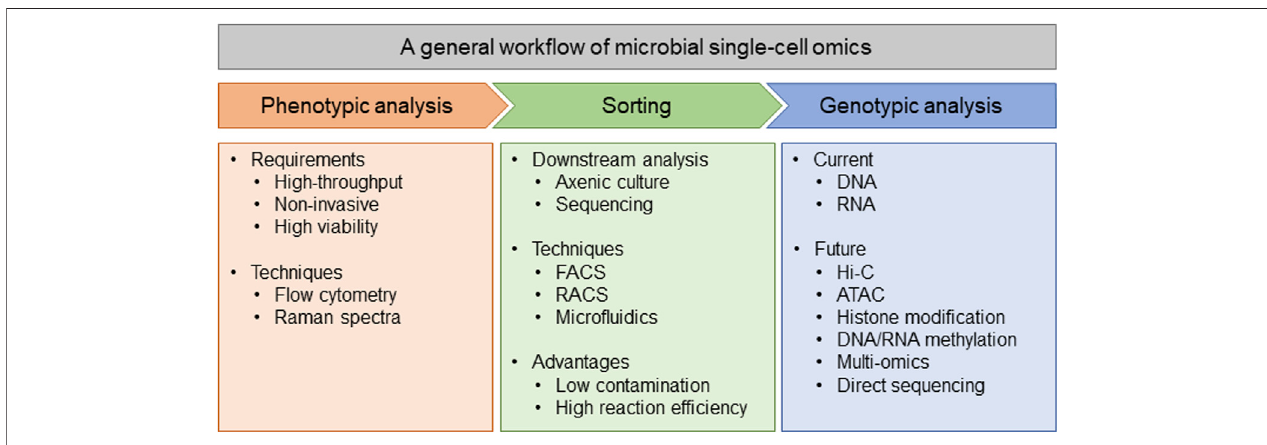
FIGURE 1 | Diagram of the general work fl ow of microbial single-cell